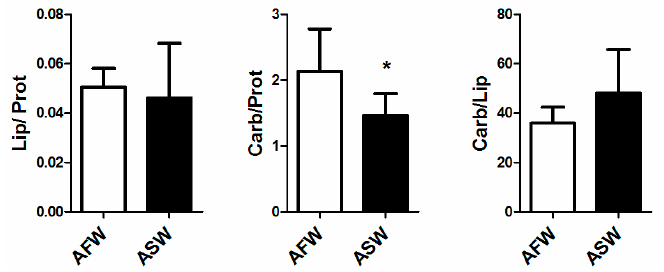
Figure 6. Lipid to protein, carbohydrate to protein and carbohydrate to lipid ratio in European sea bass muscle, reared in AFW and ASW. Statistical significance is labelled with asterisk (p < 0.05 ) , bars indicate SD.